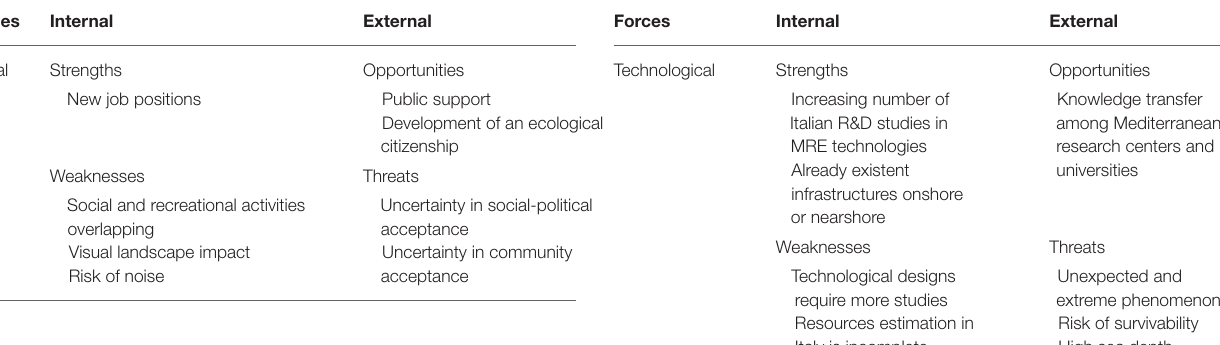
TABLE 4 | SWOT analysis of technological factors.